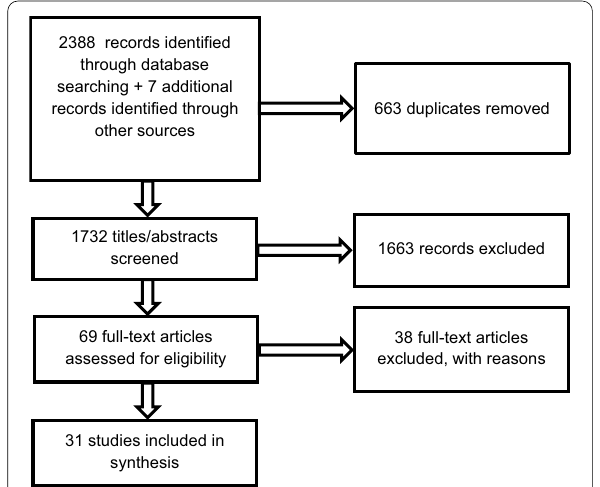
Fig. 1 PRISMA flowchart of study